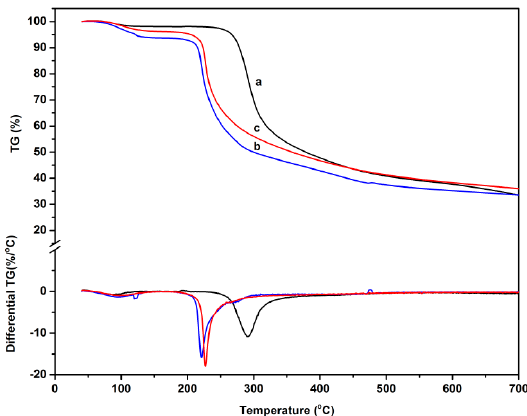
Figure 6. TG and DTG curves of a, chitosan; b, O -CMCS; and c, chitosan-based biopolymer dye.